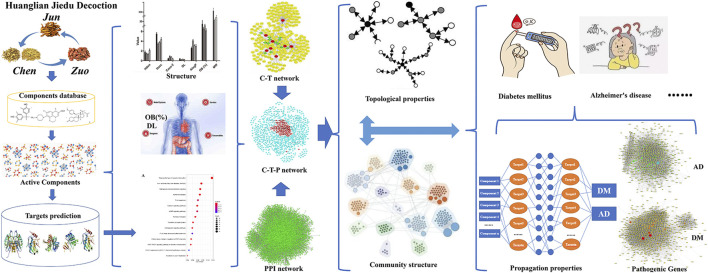
A schematic diagram of network pharmacology-based strategy to decode the principles of “Jun-Chen-Zuo-Shi” in TCM.